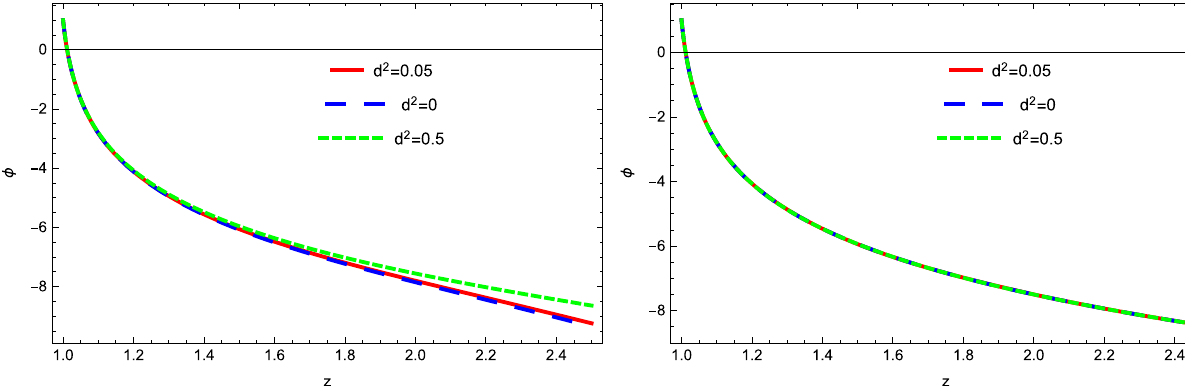
Fig. 15 Plot of φ verses z for u = 1 and u = 2 . 002 for dilaton scalar field model